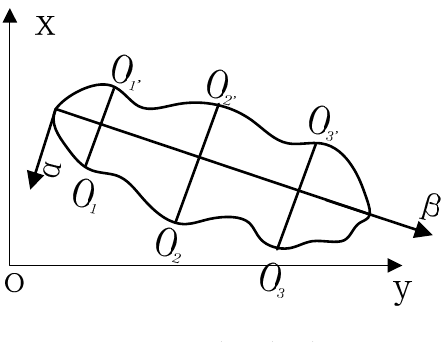
Figure 9. L1 and L2 sketch map.